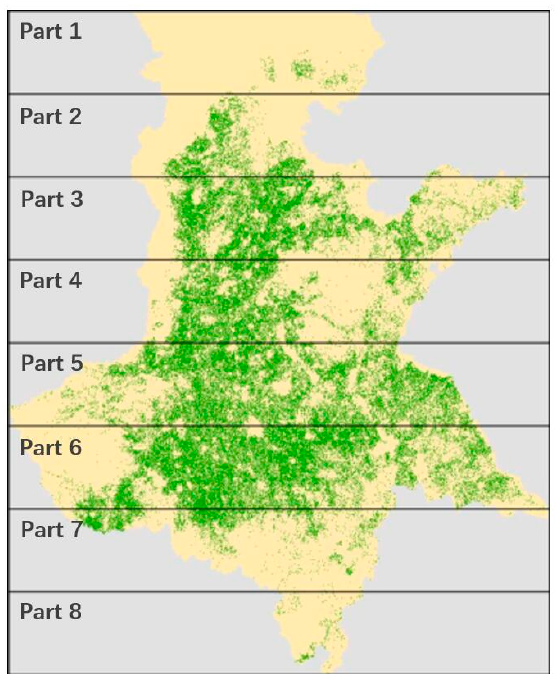
Figure 3. Geographical partitioning strategy. The whole region was partitioned into eight regions from north to south. Table 2. The number of samples in each geographically partitioned dataset.